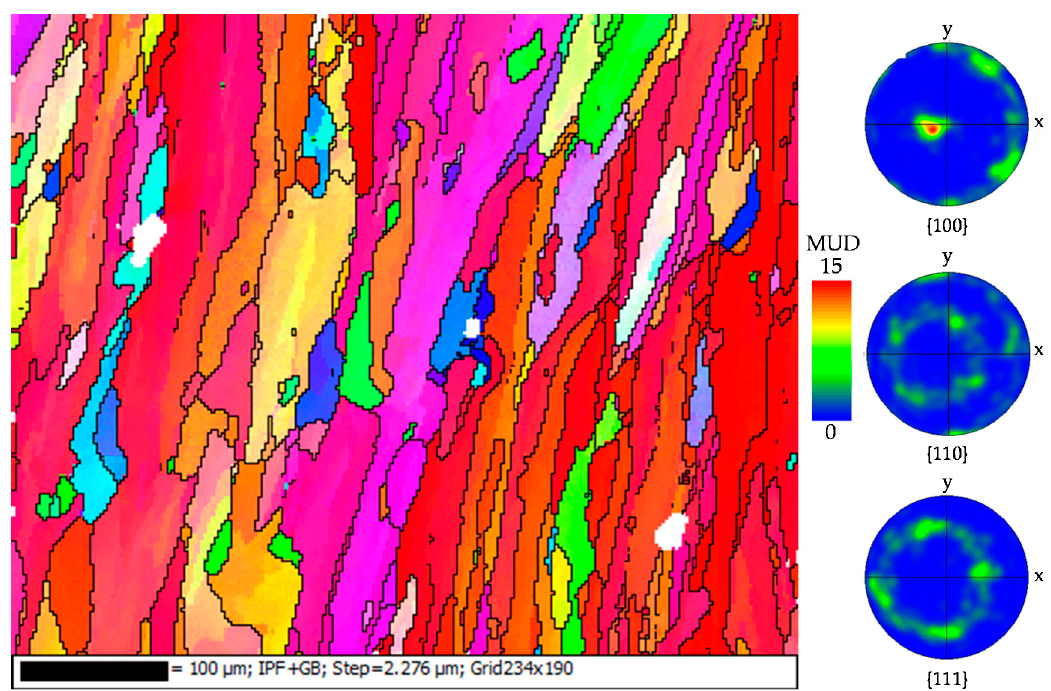
Figure A3. EBSD picture and pole figures for P L = 400 W, v s = 6500 mm/s, Δ y = 20 µm, T pre = 200 °C.